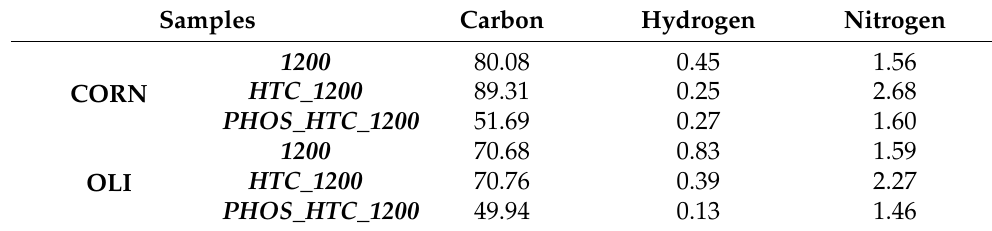
Table 2. Elemental analysis of corn cob and olive mill solid waste derived hard carbons